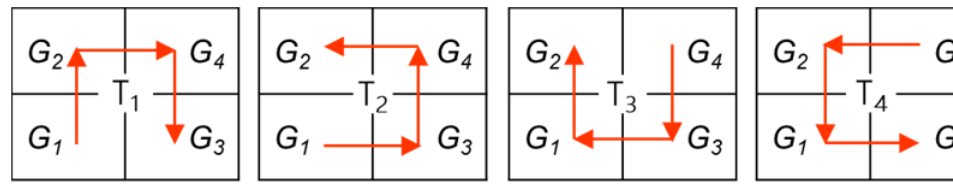
Figure 6. Basic shapes of Hilbert curve.